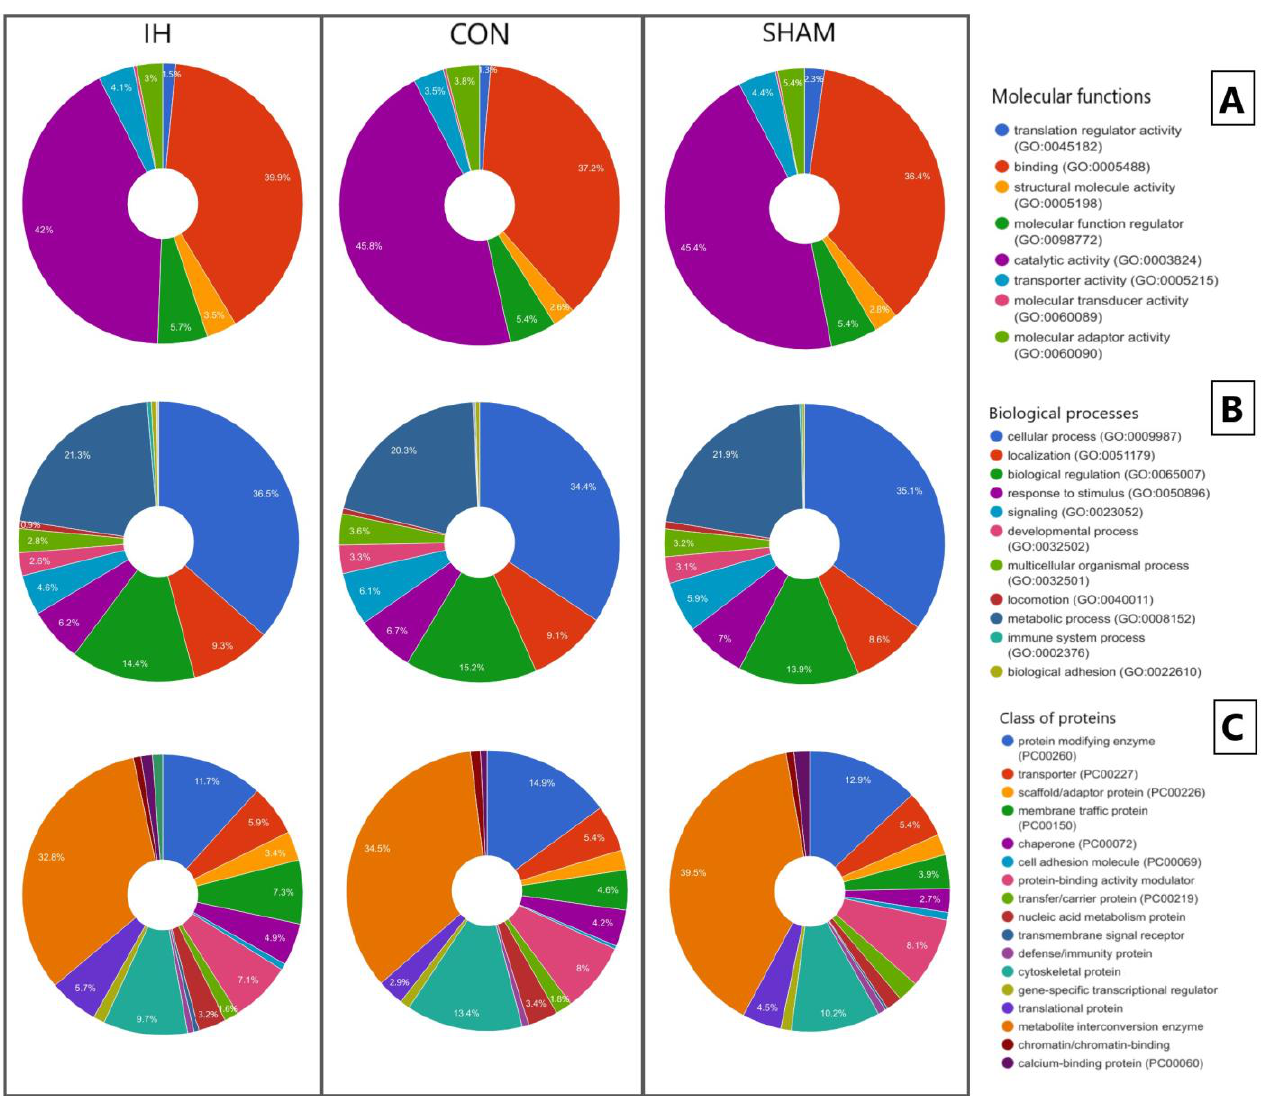
Figure 4. The PANTHER classification of the identified proteins in the brain by molecular function ( A ), biological processes ( B ), and class of proteins ( C